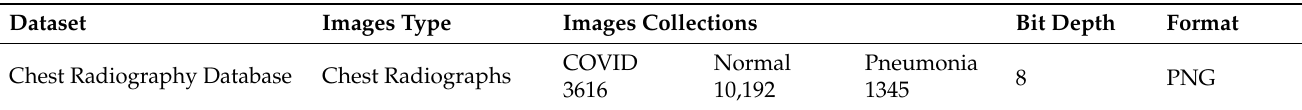
Figure 3. COVID-19 radiography database image samples, the first column have viral pneumonia, the second column has Normal, and the third column has lung obesity, whereas, the fourth column has COVID-19 chest radiograph images. Table 3. Datasets